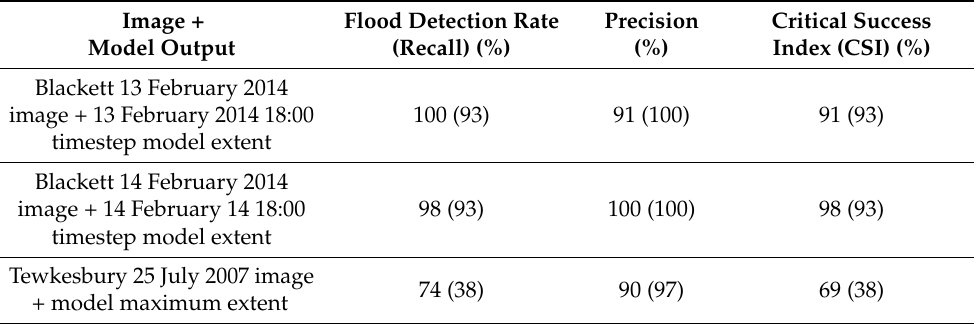
Figure 11. Flood Foresight monitoring output centred on Blackett Close Staines ( a ) at 12 February 2014 18:00 near flood peak and ( b ) at 21 February 2014 18:00 when waters have receded. The blue shades indicate flooding to various depths, with darker blue being deeper flooding. Table 4. Urban flood detection accuracy using rural SAR WLOs, FRP maps, and dynamic Flood Foresight model output (figures in brackets are for model output